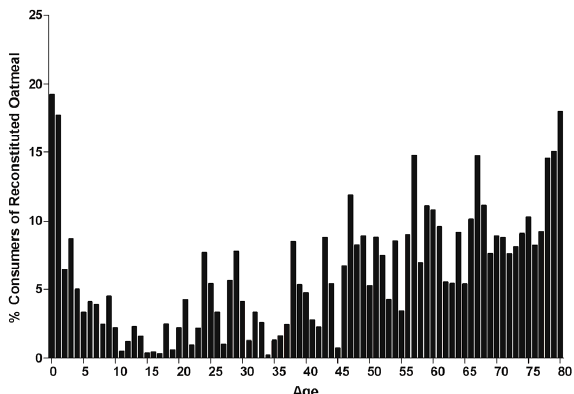
Figure 1. Distribution of consumers of cooked oatmeal according to the proportion of consumers within each age group. Percentage (%) of total number of respondents within an age year who were identified as consumers of cooked oatmeal within the 2009–2012 NHANES. A respondent was considered a consumer of cooked oatmeal if they consumed any of the foods represented by the food codes listed in Table 1 on Day 1 of the survey. It should be noted that individuals aged 80 years or older are top coded at 80 years of age.